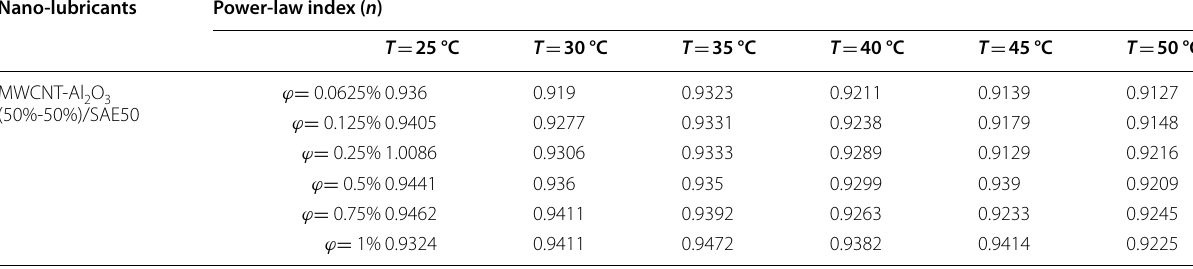
Table 4 Power-law index values at different ϕ and T Nano-lubricants Power-law index ( n